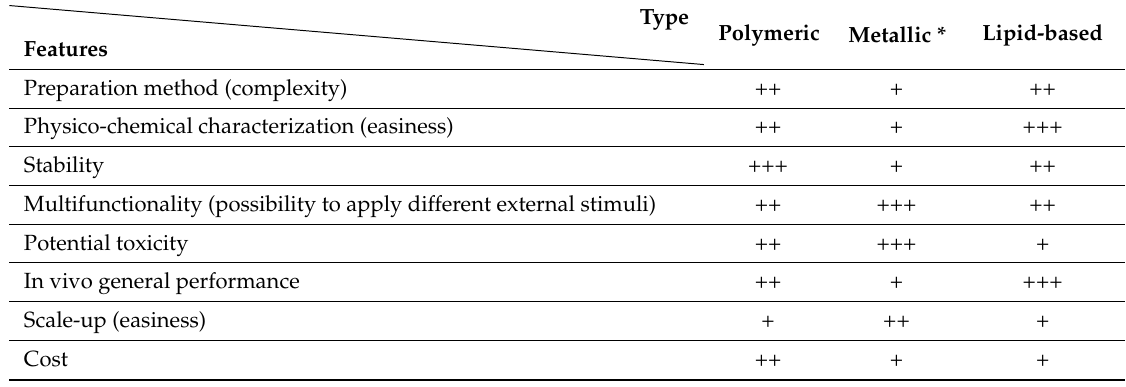
Table 4. The performance of metallic, polymeric, and lipid-based nanosystems as cancer nanotheranostics. Type Polymeric Metallic * Lipid-based Features Preparation method (complexity) ++ + ++ Physico-chemical characterization (easiness) ++ + +++ Stability +++ + ++ Multifunctionality (possibility to apply different external stimuli) ++ +++ ++ Potential toxicity ++ +++ + In vivo general performance ++ + +++ Scale-up (easiness) + ++ +